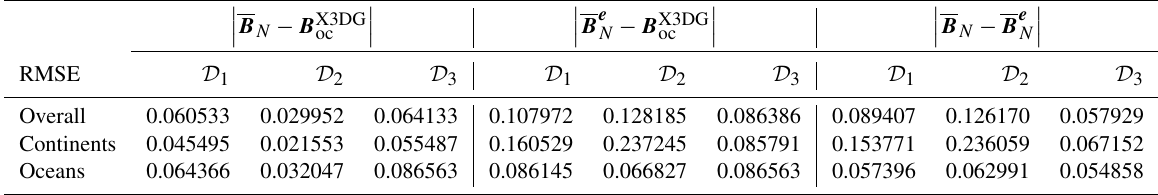
Table 1. Root mean square errors (RMSEs) corresponding to the approximations of the undisturbed forward model B X3DG oc as well as the noisy model B e oc = B X3DG oc + e compared to the “ground truth” B X3DG oc with the three different dictionaries. Left-hand columns show errors for the approximation of B X3DG oc (compare Fig. 7), while center columns show errors for the approximation of B e oc (compare Fig. 9). The right-hand columns display the RMSEs of the difference between the respective approximations (as shown in Fig.